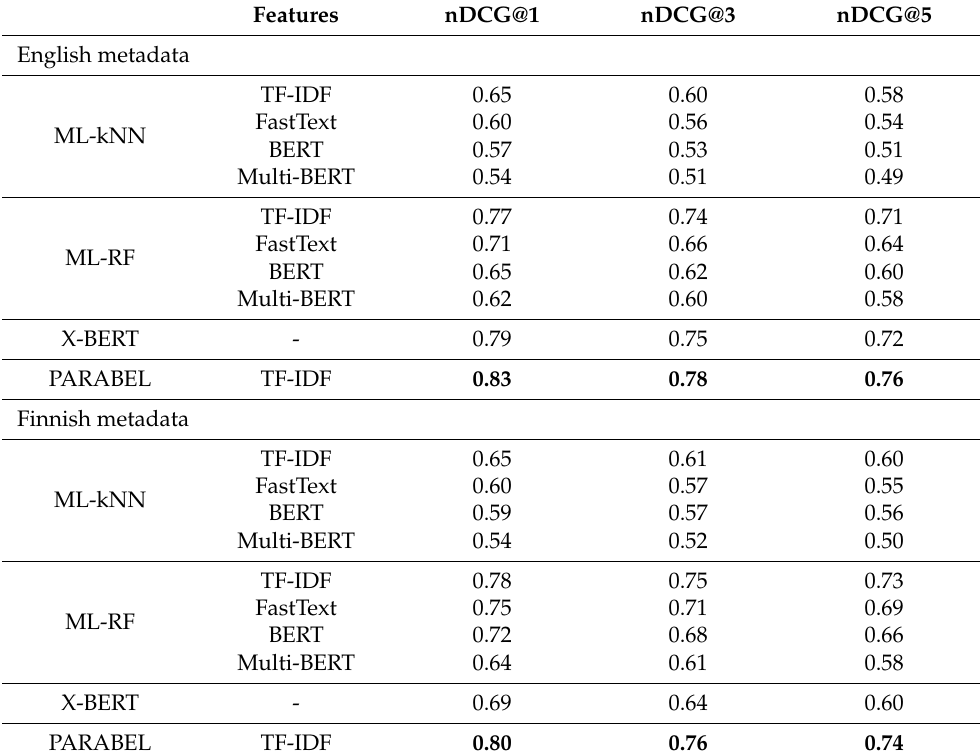
Table 4. Ranking scores obtained from the evaluation of the models in the English and Finnish test datasets.